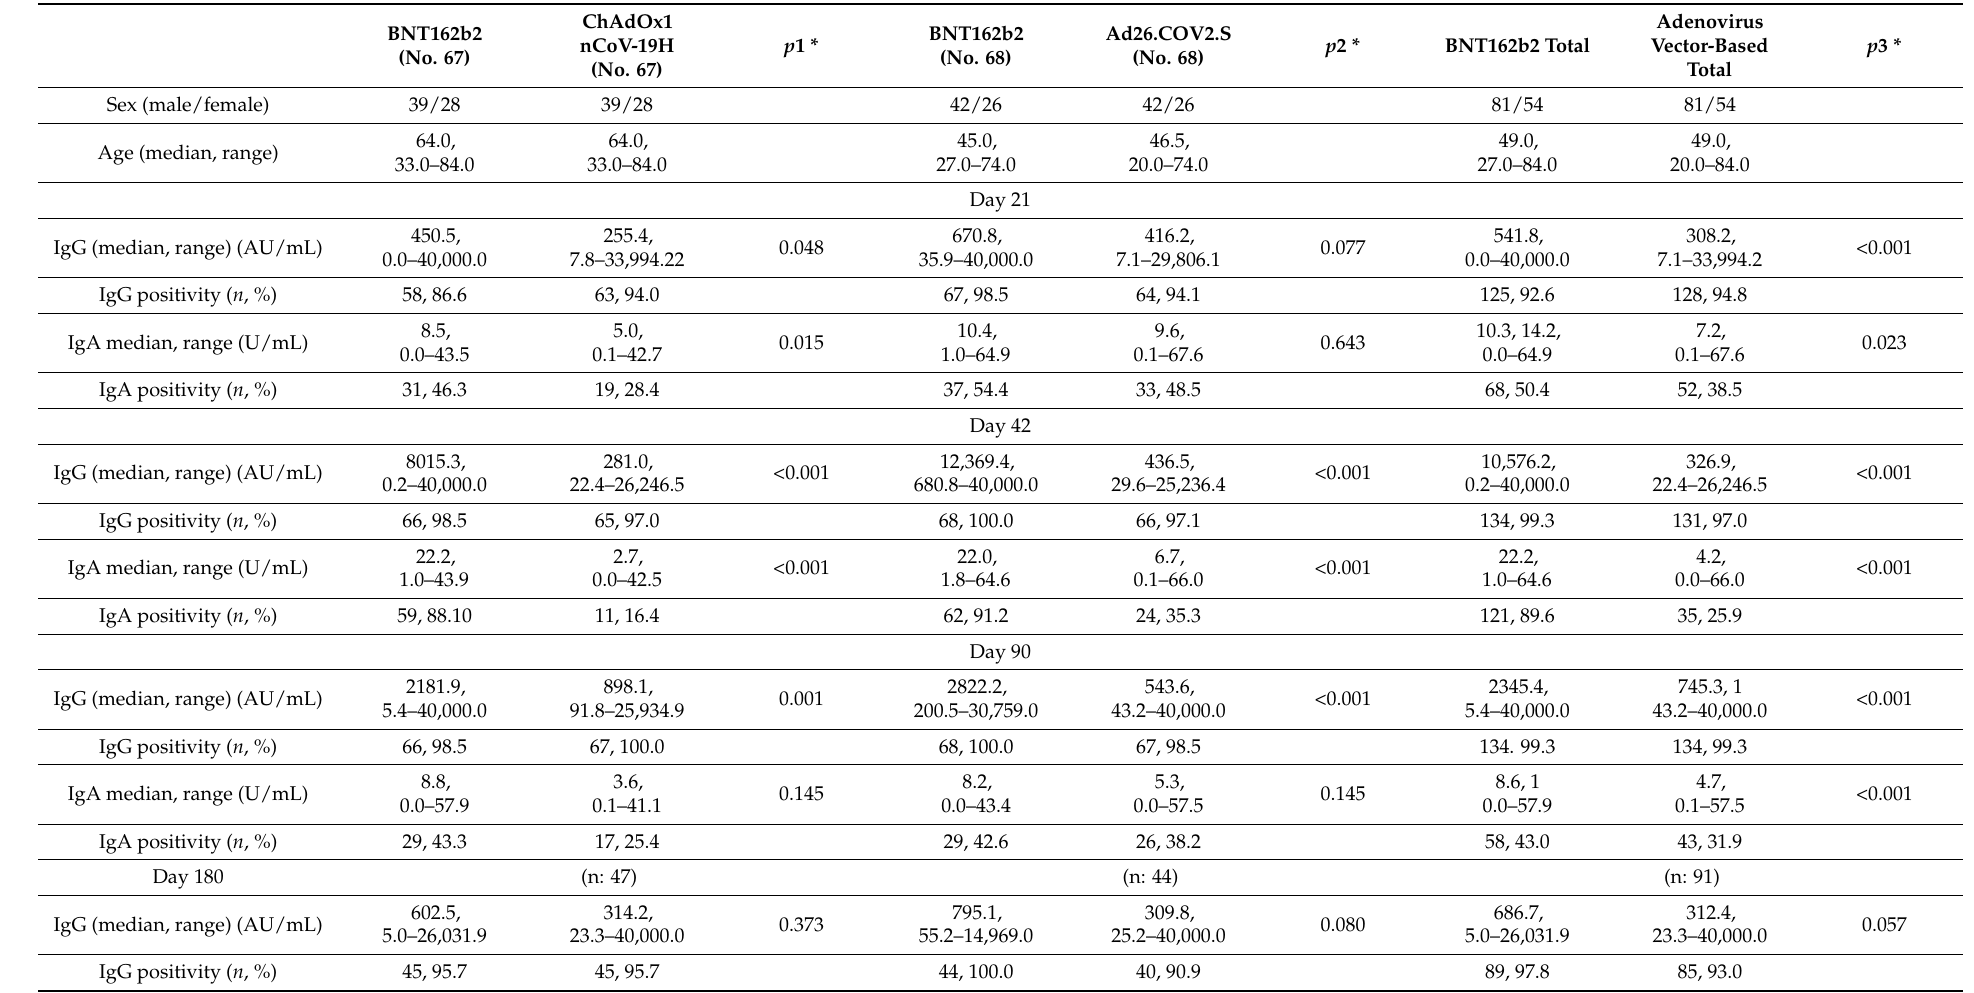
Table 4. IgG and IgA immune responses 21, 42, 90, and 180 days after